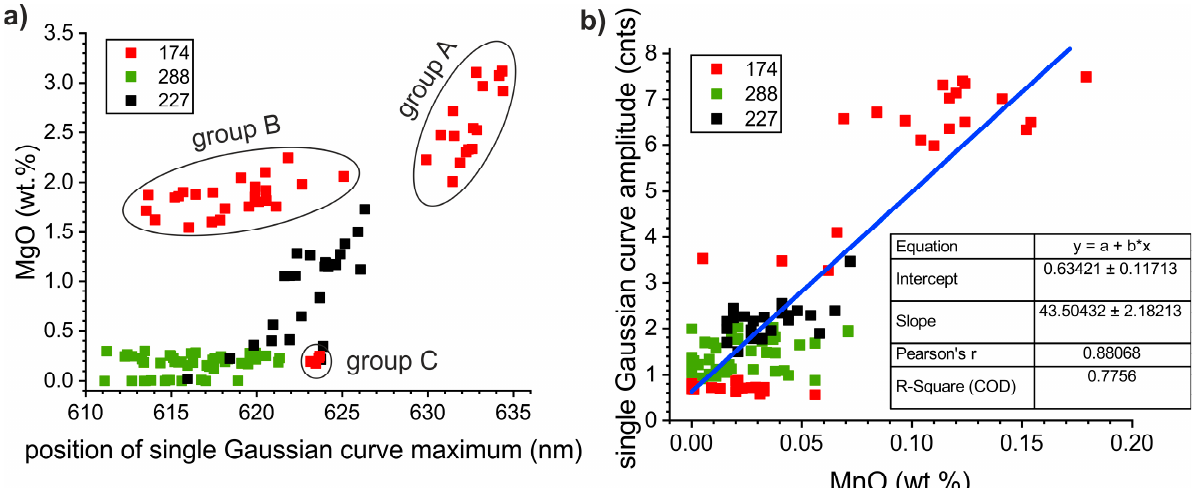
Figure 10. Correlation of parameters derived from Gaussian fits of CL-spectra and Mg- ( a ) and Mn- ( b ) admixtures of calcite: ( a ) plot of all spectra with highlighted three groups (A—veinlets, B—groundmass of the calcitic type of dolomitic marble, C—groundmass of the dolomitic marble type with secondary calcite veins) of data of sample No. 174; ( b ) correlation between intensity of extrinsic CL of calcite and Mn content. Sample No. 174—Raspenava, sample No. 227—Bohdane č , sample No. 288—Nedv ě dice.